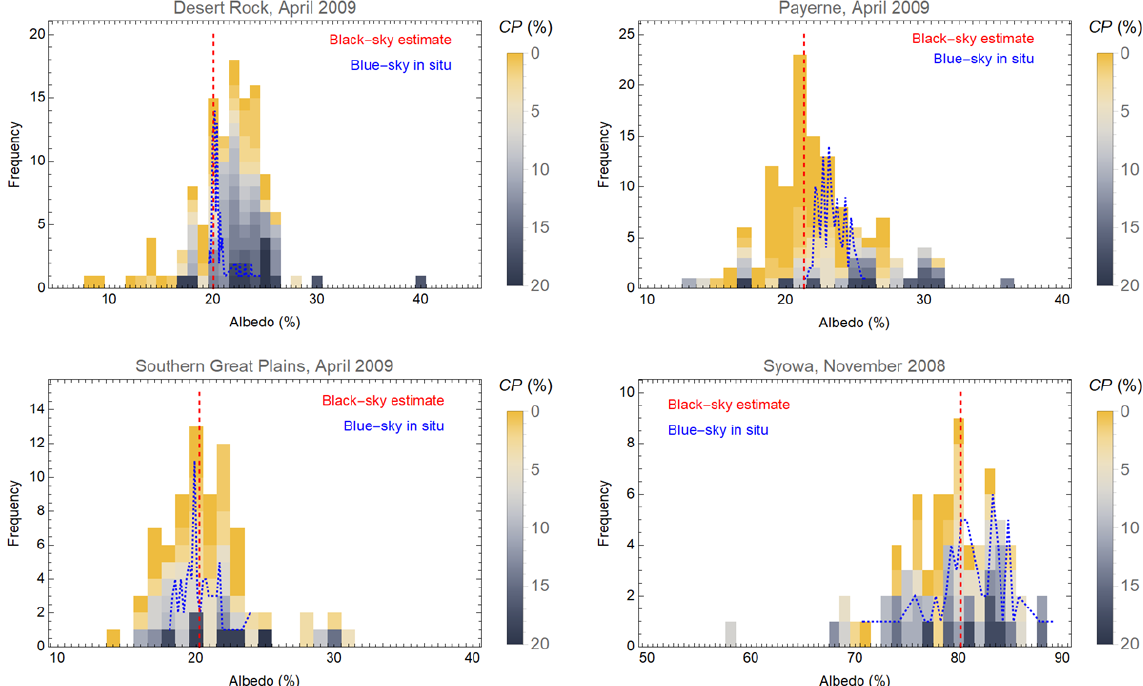
Figure 5. The albedo retrieval distributions at Desert Rock, Payerne and Southern Great Plains in April 2009 and Syowa in November 2008. The cloud probability values of the individual black-sky satellite-based estimates are indicated by colours. The monthly mean estimate is shown as a red line. The in situ measured monthly blue-sky albedo distribution is shown in